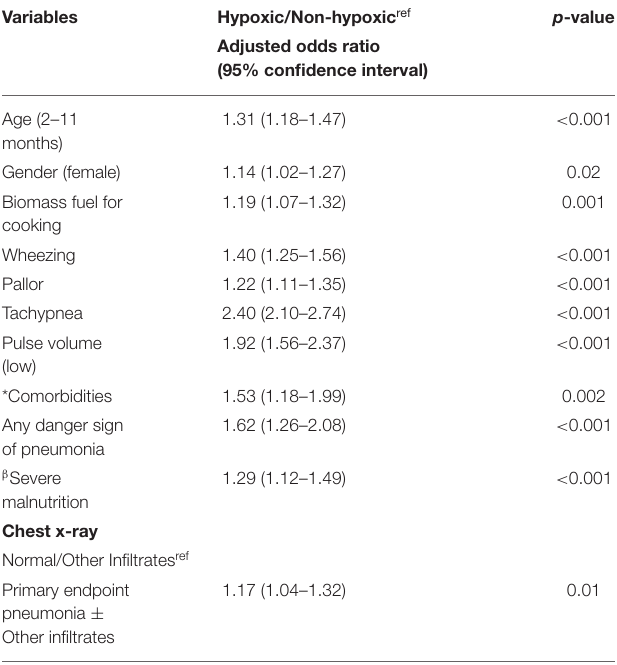
TABLE 2 | Conditional logistics regression to assess association of hypoxic community pneumonia with sociodemographic, clinical, and radiological